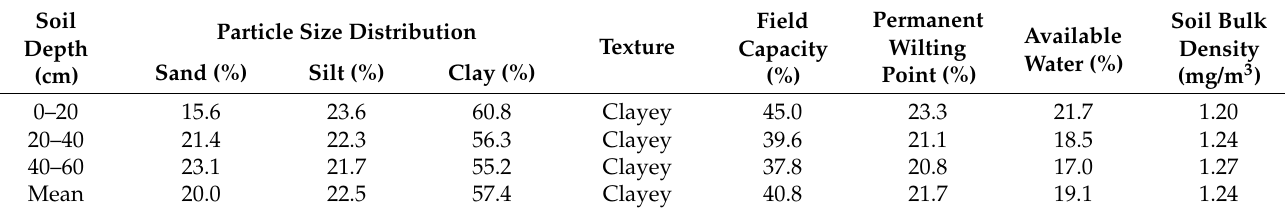
Table 1. Physical properties, water parameters and bulk density of the experimental soil.